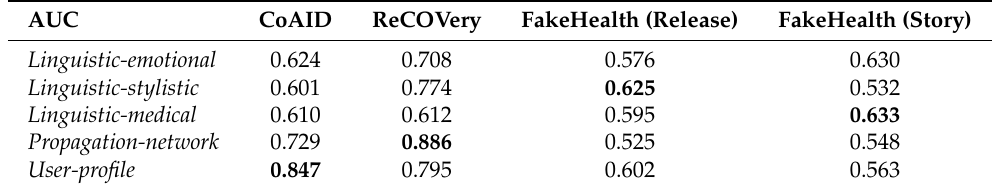
Table 7. Evaluation of effectiveness by feature class.